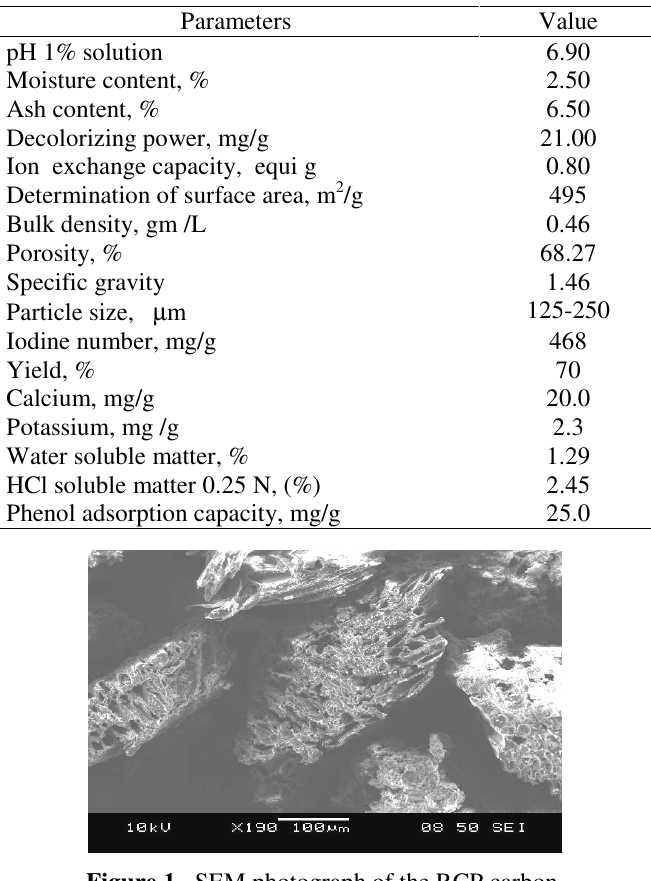
Table 1. Characteristic of RCP carbon.